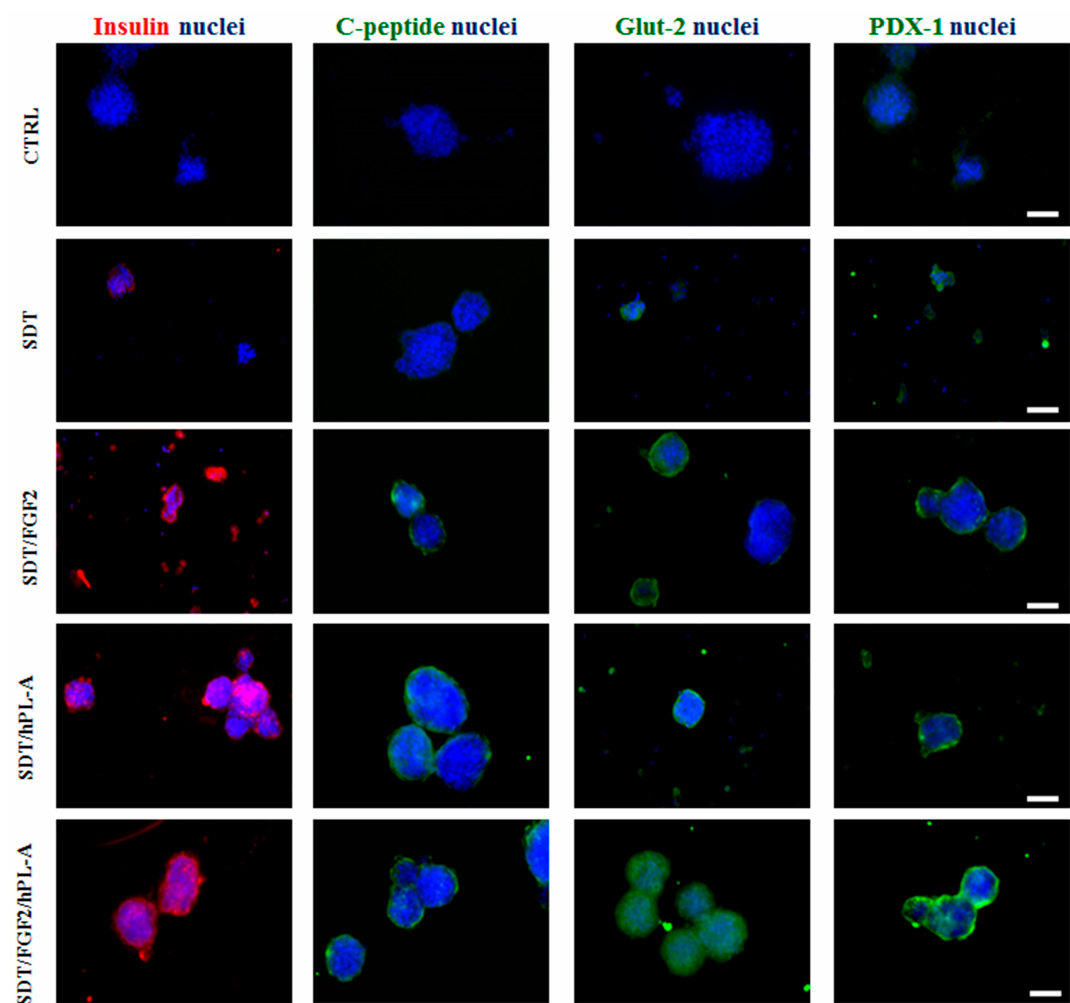
Figure 4. Immunofluorescence analysis of islet-like aggregates obtained from non-endocrine pancreatic cells isolated from healthy donors. Non-endocrine pancreatic cells obtained from healthy donors after the procedure for islet isolation were incubated with serum-free medium supplemented with 0.1% BSA plus 1.1 mg/L transferrin (SDT). SDT medium was then supplemented with 500 ng/mL FGF-2b or 500 ng/mL hPL-A, or both hormones (FGF-2b/hPL-A). After 48 h, stimuli were renewed and, following 96 h, cell aggregates were fixed and stained for the expression of insulin ( red ), C-peptide, Glut-2, and PDX-1 ( green ). Nuclei were blue-stained by Hoechst. Scale bar = 50 μ m. CTRL: control, untreated non-endocrine pancreatic tissue from healthy donors.